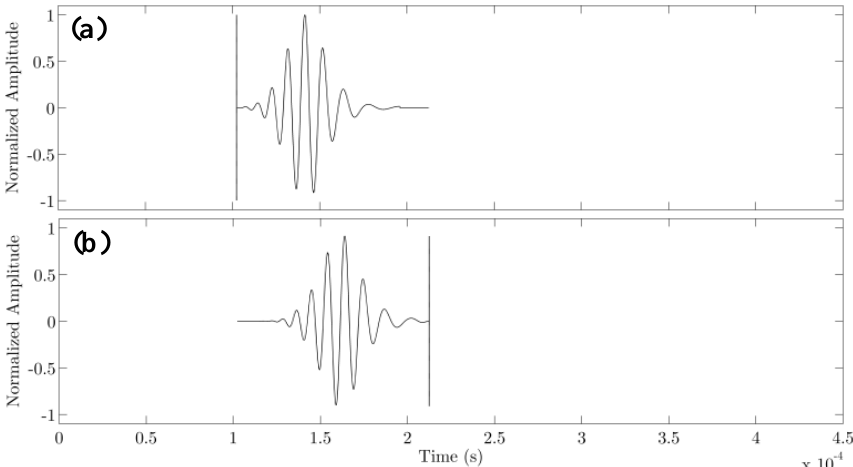
Figure 6. Shortening of the signals to reduce computational time. The same limits are used to truncate each signal in order to maintain the time difference between wavepackets. Signals acquired at: ( a ) 30 cm and ( b ) 35 cm from the transmitter.